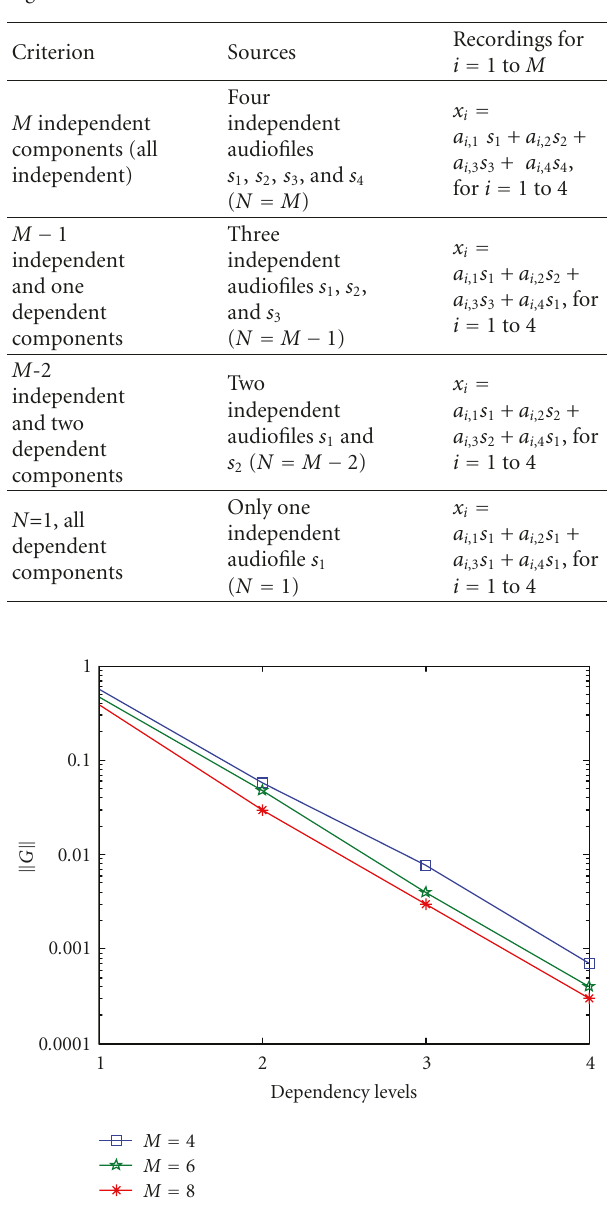
Figure 1: Logarithmic plot (cid:3) G (cid:3) against dependency levels . Depen- dency level 1 corresponds with N = M , 2 corresponds with N = M − 1, 3 corresponds with N = M − 2, and 4 corresponds with N =